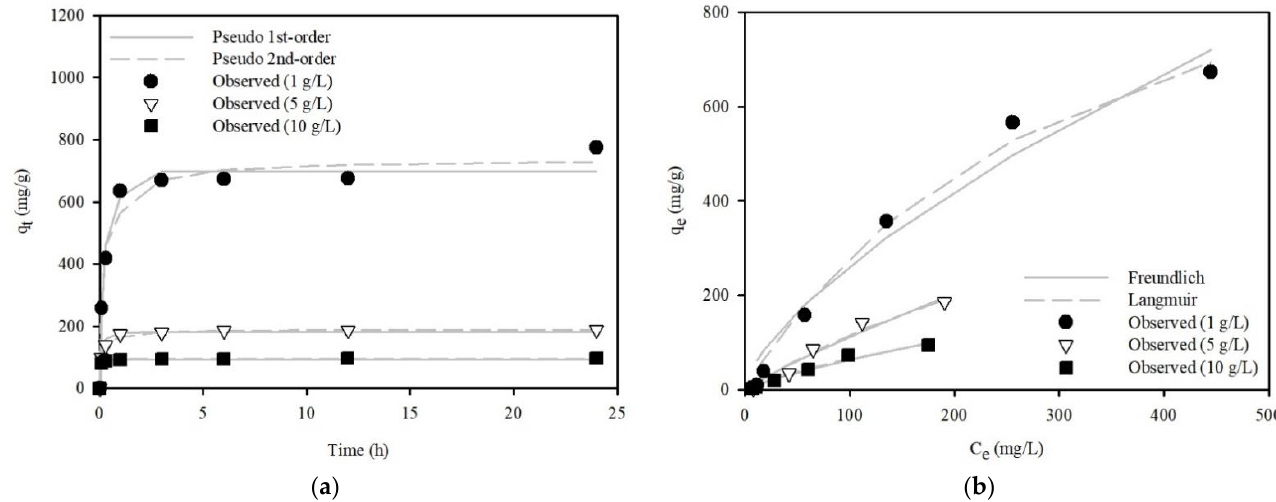
Figure 10. ( a ) MR adsorption kinetics fitted by pseudo-first-order and pseudo-second-order models onto the WFD/SA-PEI bead. ( b ) Adsorption isotherm of MR onto the WFD/SA-PEI bead (pH: 4.0; contact time: 3 h). Table 6. MR removal capacities of various low-cost adsorbents reported in the literature.